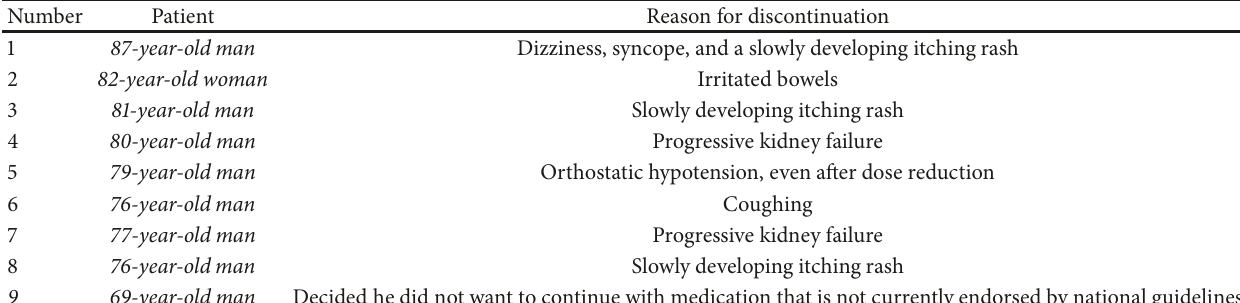
Table 2: Reasons for discontinuation of sacubitril-valsartan within first year.